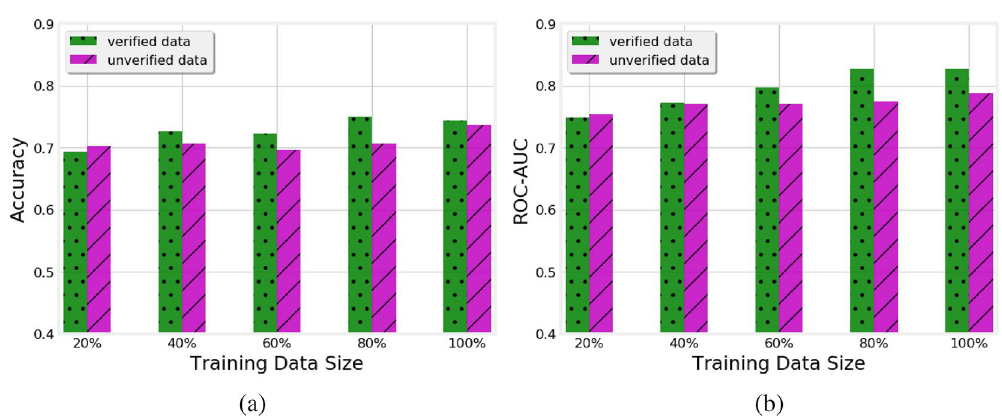
Figure 2. Impact of the volume of verified and unverified training data on ( a ) accuracy and ( b ) AUC of the RF